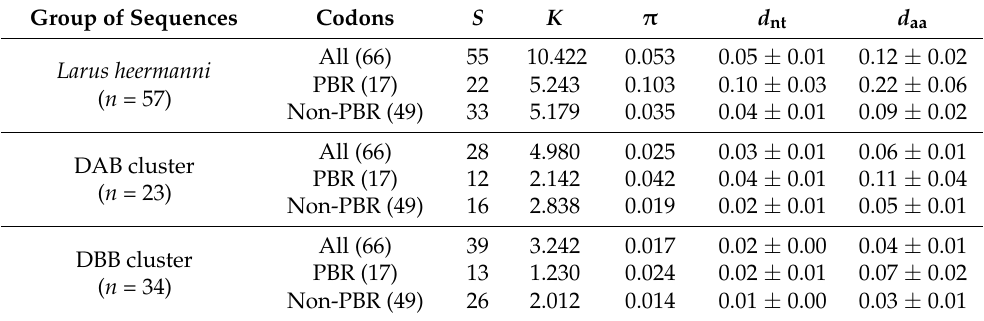
Table 1. Genetic diversity of the 66 codons from the MHCIIB haplotypes of Heermann’s Gull. Codons of the peptide-binding regions (PBRs) as well as the non-peptide-binding-regions (non-PBRs) were inferred based on the human antigen-binding groove [46,47]. Both numbers of haplotypes ( n ) and codons examined are shown in